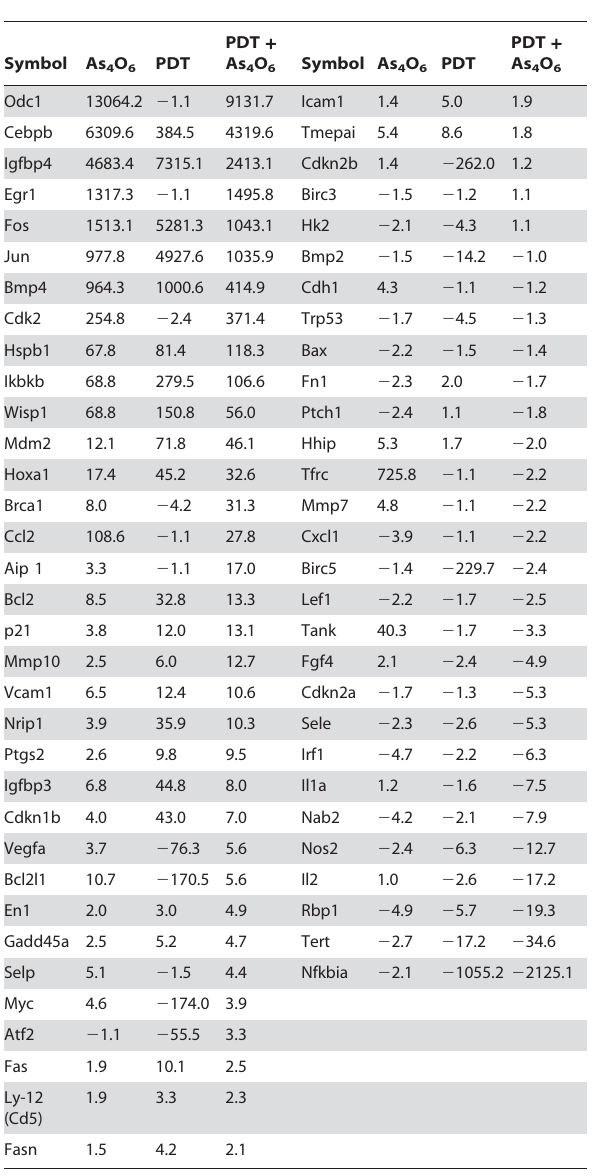
Table 2. Gene expression profiles of TC-1 cells treated with 0.15 ug/ml Radachorin/PDT and/or 3 uM of As 4 O 6 for 1 day.